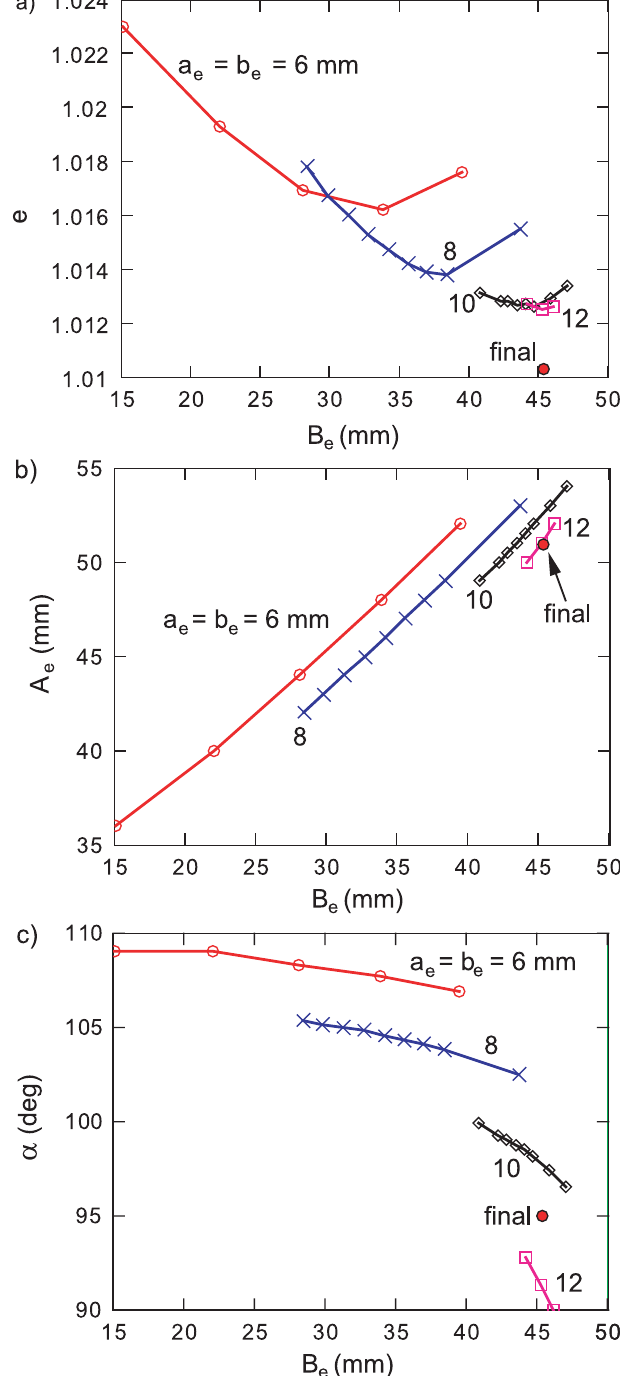
FIG. 8. (Color) Normalized electric field e envelopes (a), length (b), and the wall slope angle (cid:1) (c) for of the half-axis A e ¼ b ) vs length of different circular roundings of the iris ( a e e . The single point is the final result. the other half-axis, B e